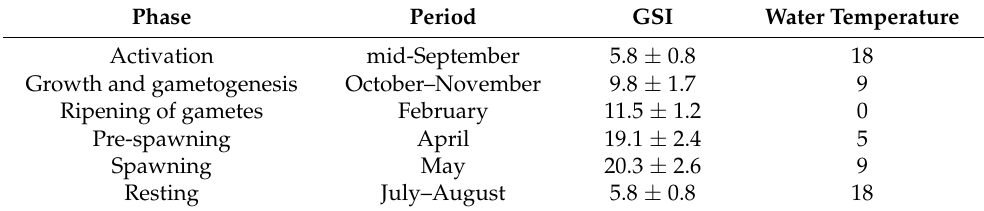
Table 1. Gonadosomatic index (GSI) at different stages of the yesso scallop gametogenic cycle in the Sea of Japan in relation to water temperature [27].